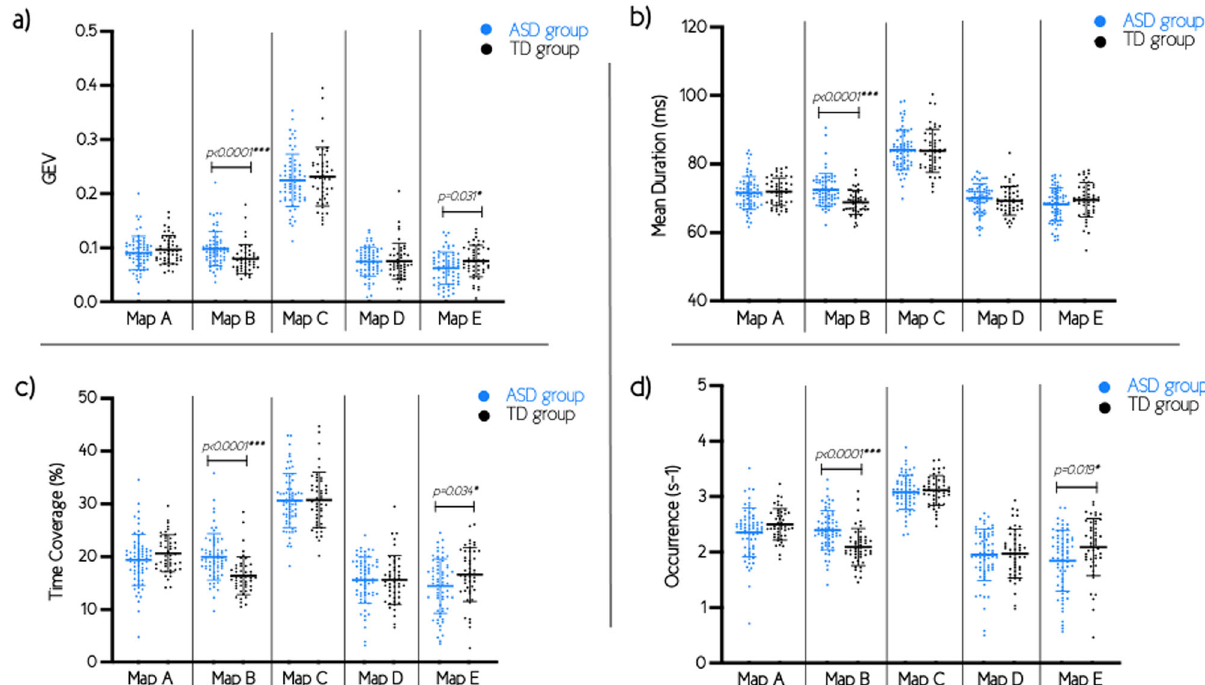
Fig. 3 Temporal parameters of the microstates. Results of both autism spectrum disorders (ASD) and typically developing (TD) groups for the temporal parameters: a global explained variance (GEV); b mean duration; c time coverage; and d occurrence. Error bars represent means and standard deviations.